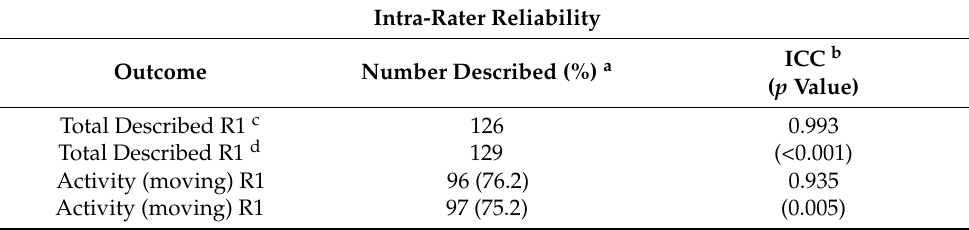
Table 2. Intra- and inter-class correlation coefficients for each outcome